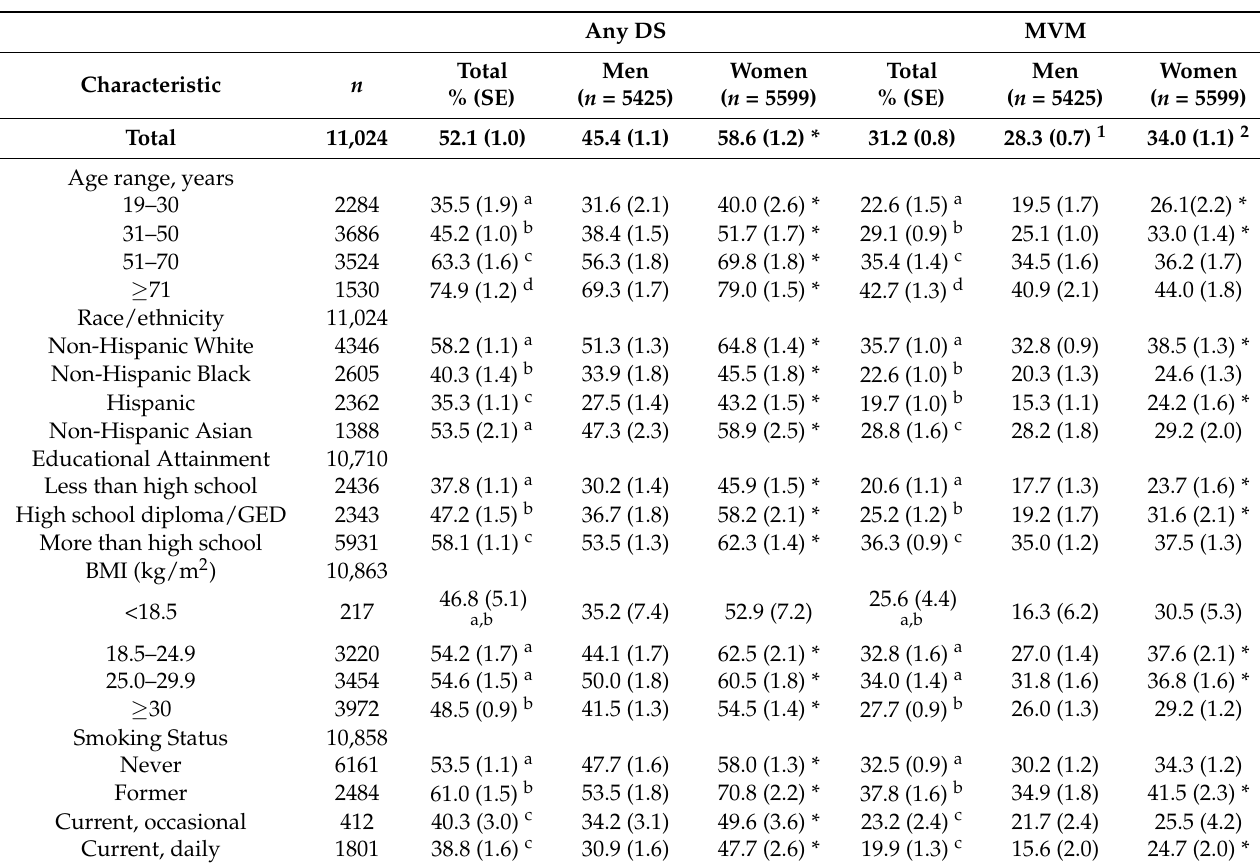
Table 1. Estimated prevalence (%) of any dietary supplement (DS) use and multivitamin-mineral (MVM) use by demographic, anthropometric, and